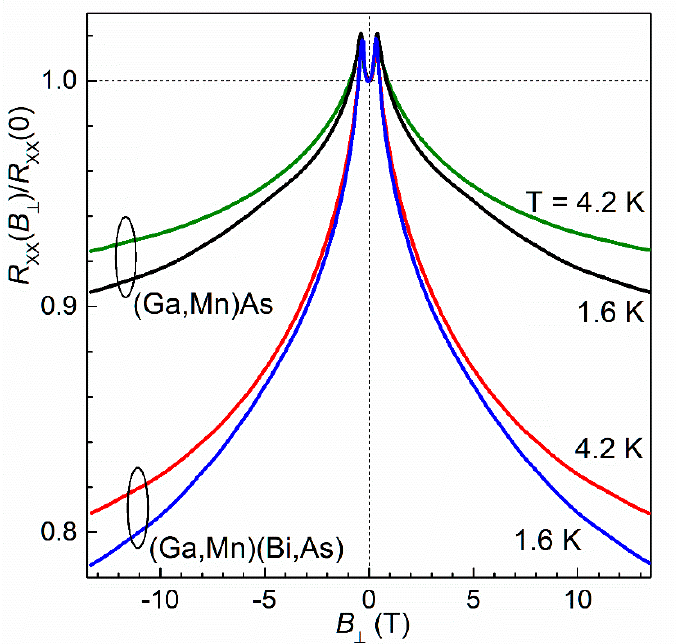
Figure 6. Relative longitudinal resistance measured for the Hall bars of (Ga,Mn)(Bi,As) and (Ga,Mn)As layers at temperatures of 1.6 K and 4.2 K, while sweeping an external magnetic field perpendicular to the layer plane in opposite directions.